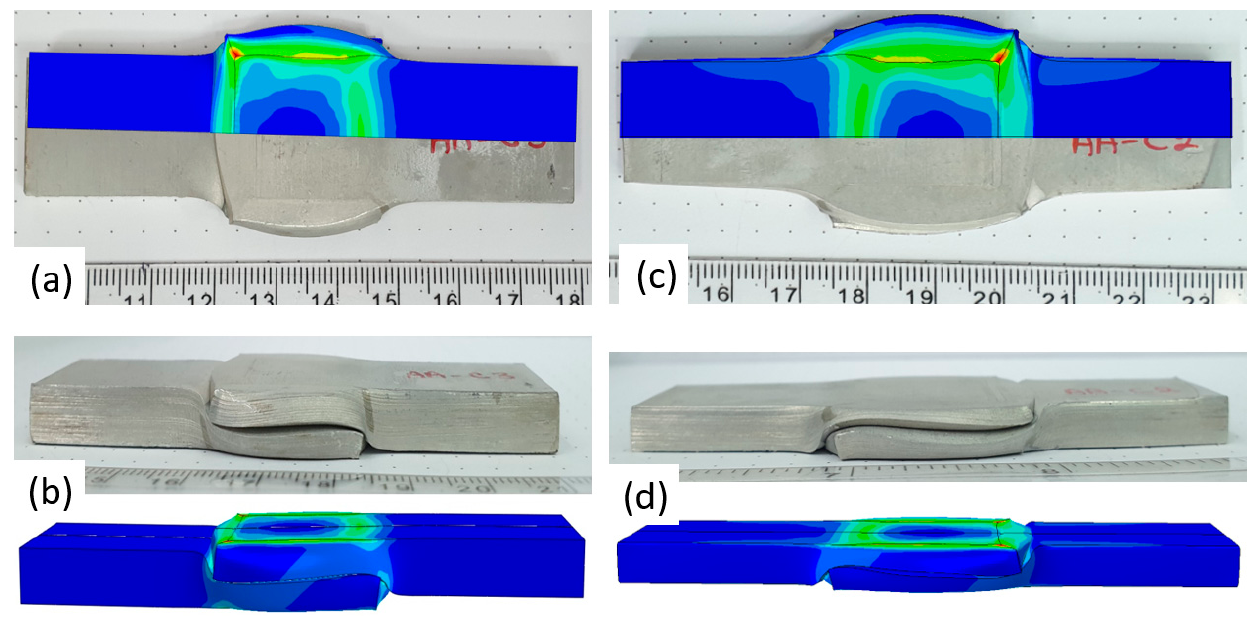
Figure 6. Upper ( a ) and side ( b ) view of specimen AAC3. Upper ( c ) and side ( d ) view of specimen AAC2. Table 3. Approximated τ bonding from force obtained in tension and area from the compression stage. Temperature [ ◦ C] Specimen